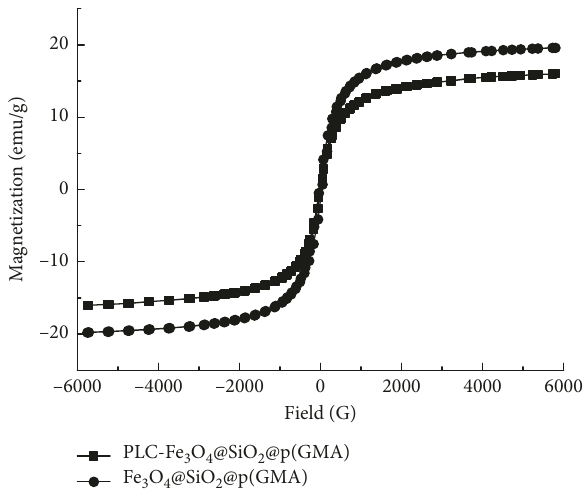
Figure 4: Magnetic hysteresis loop. The specific saturation mag- netization was found to be 19.70 ± 0.60emu/g and 16.00 ± 0.20emu/g for Fe 3 O 4 @SiO 2 @p(GMA) and PLC-Fe 3 O 4 @SiO 2 @ p(GMA),